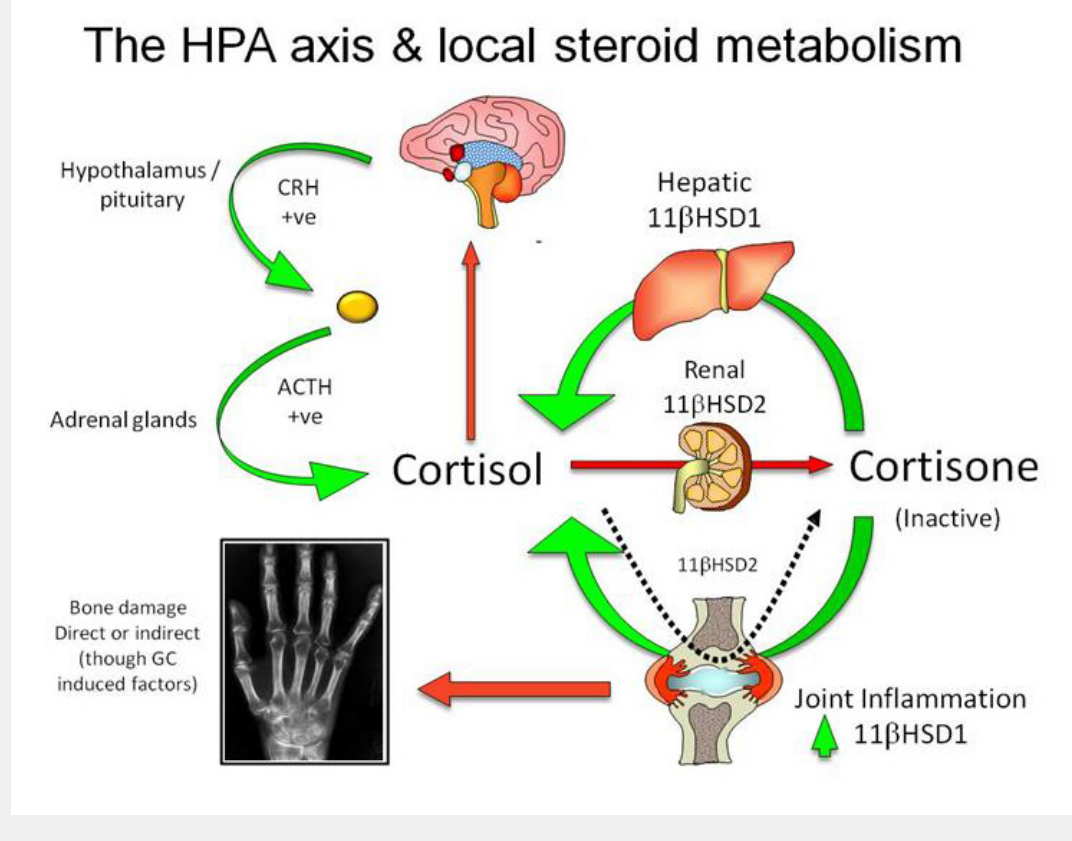
The integration of the local metabolism of cortisol within the liver, kidneys and inflamed tissues, with systemic regulation of circulating cortisol by the HPA axis. Hepatic 11β-HSD1 reactivates circulating cortisone, whilst renal 11β-HSD2 expression inactivates cortisol. During inflammation, elevated 11β-HSD1 expression within inflamed tissues amplifies the local cortisol concentration, which can result in detrimental side effects such as bone loss in inflammatory disease. Persistent 11β-HSD2 expression within specific leukocyte subsets during inflammation will confer steroid